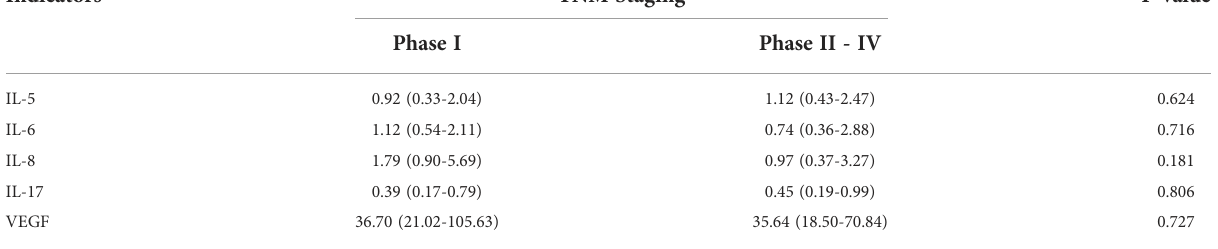
TABLE 5 Cytokines associated with TNM staging.